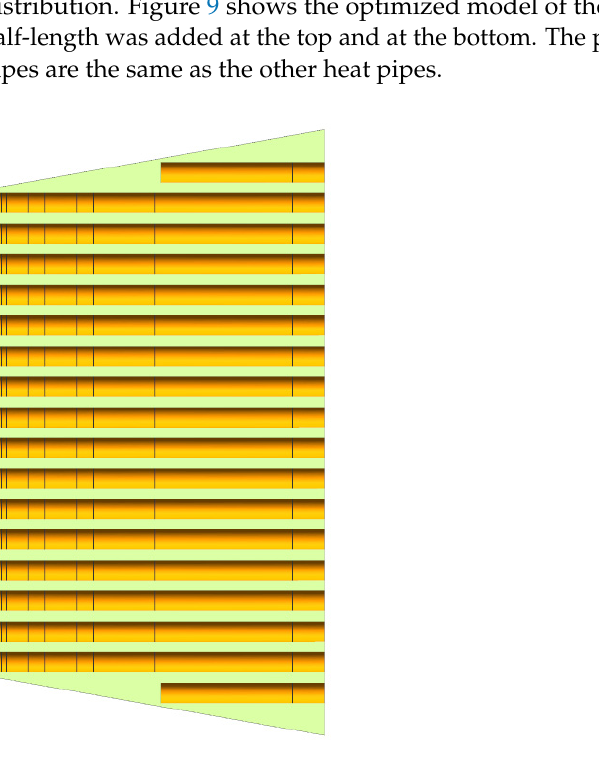
Figure 9. The side-view cross section of the optimized blanket. The maximum temperature distribution of the optimized blanket design is shown in Figure 10. The maximum temperature of BP is 584.0 K, which is much lower than the limit (773.15). In addition, none of the zones’ maximum temperatures exceed the limit. Figure 11 shows the temperature contour of the XC–ZC cross-section of the optimized blanket center. Compared with Figure 7, the high temperature zones have disappeared.